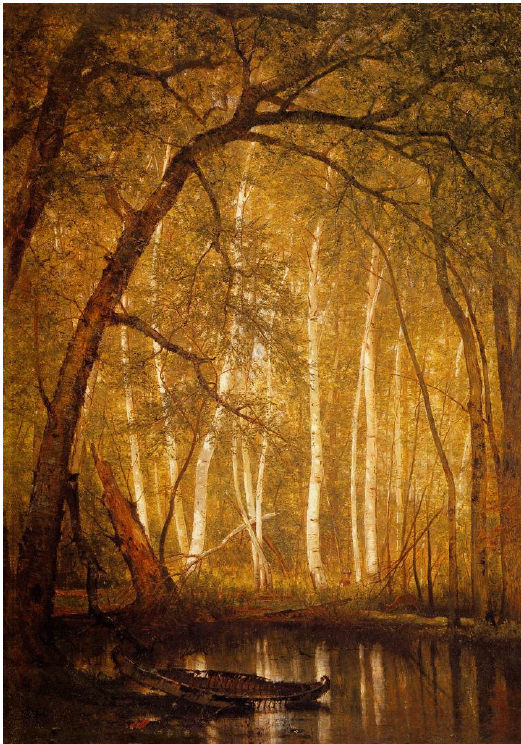
Figure 2. The Old Hunting Grounds by Worthington Whittredge 1864. Oil on canvas. Reynolda House Museum of American Art.